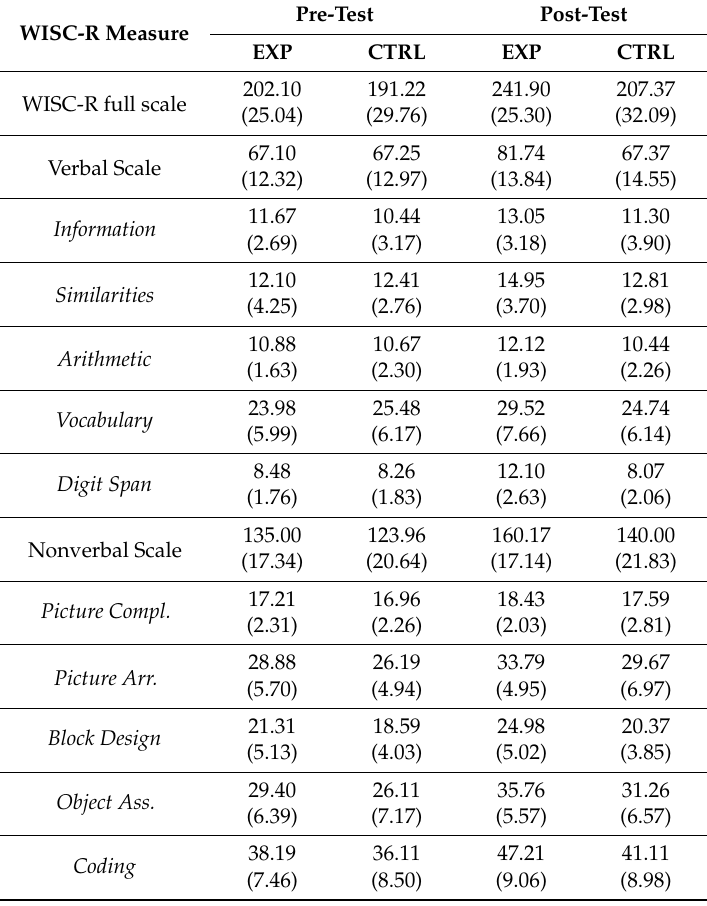
Table 3. Mean raw scores in WISC-R full scale, Verbal and Nonverbal scales, and 10 subtests, obtained by two groups (experimental and control) at two testing points (pre-test and post-test). Standard deviations are presented in